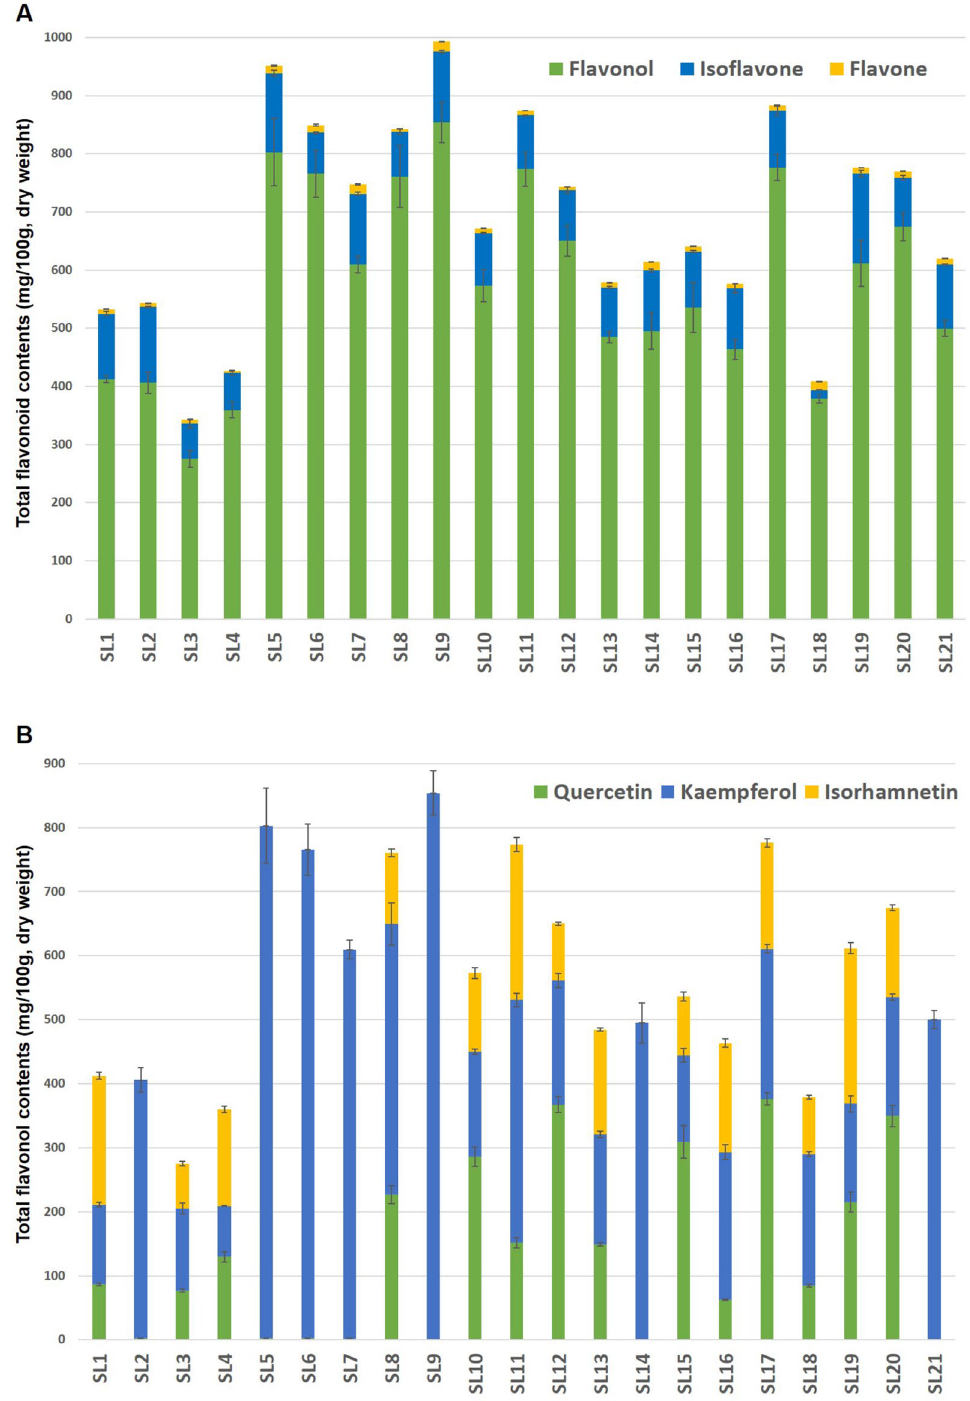
Figure 2. Comparison in total contents (mg/100 g, dry weight) according to flavonoid ( A ) types (flavonol, flavone and isoflavone) as well as flavonol ( B ) aglycones (quercetin, kaempferol and isorhamnetin) and ( C ) glycosides (mono-, di- and tri-) in young leaves of 21 soybean